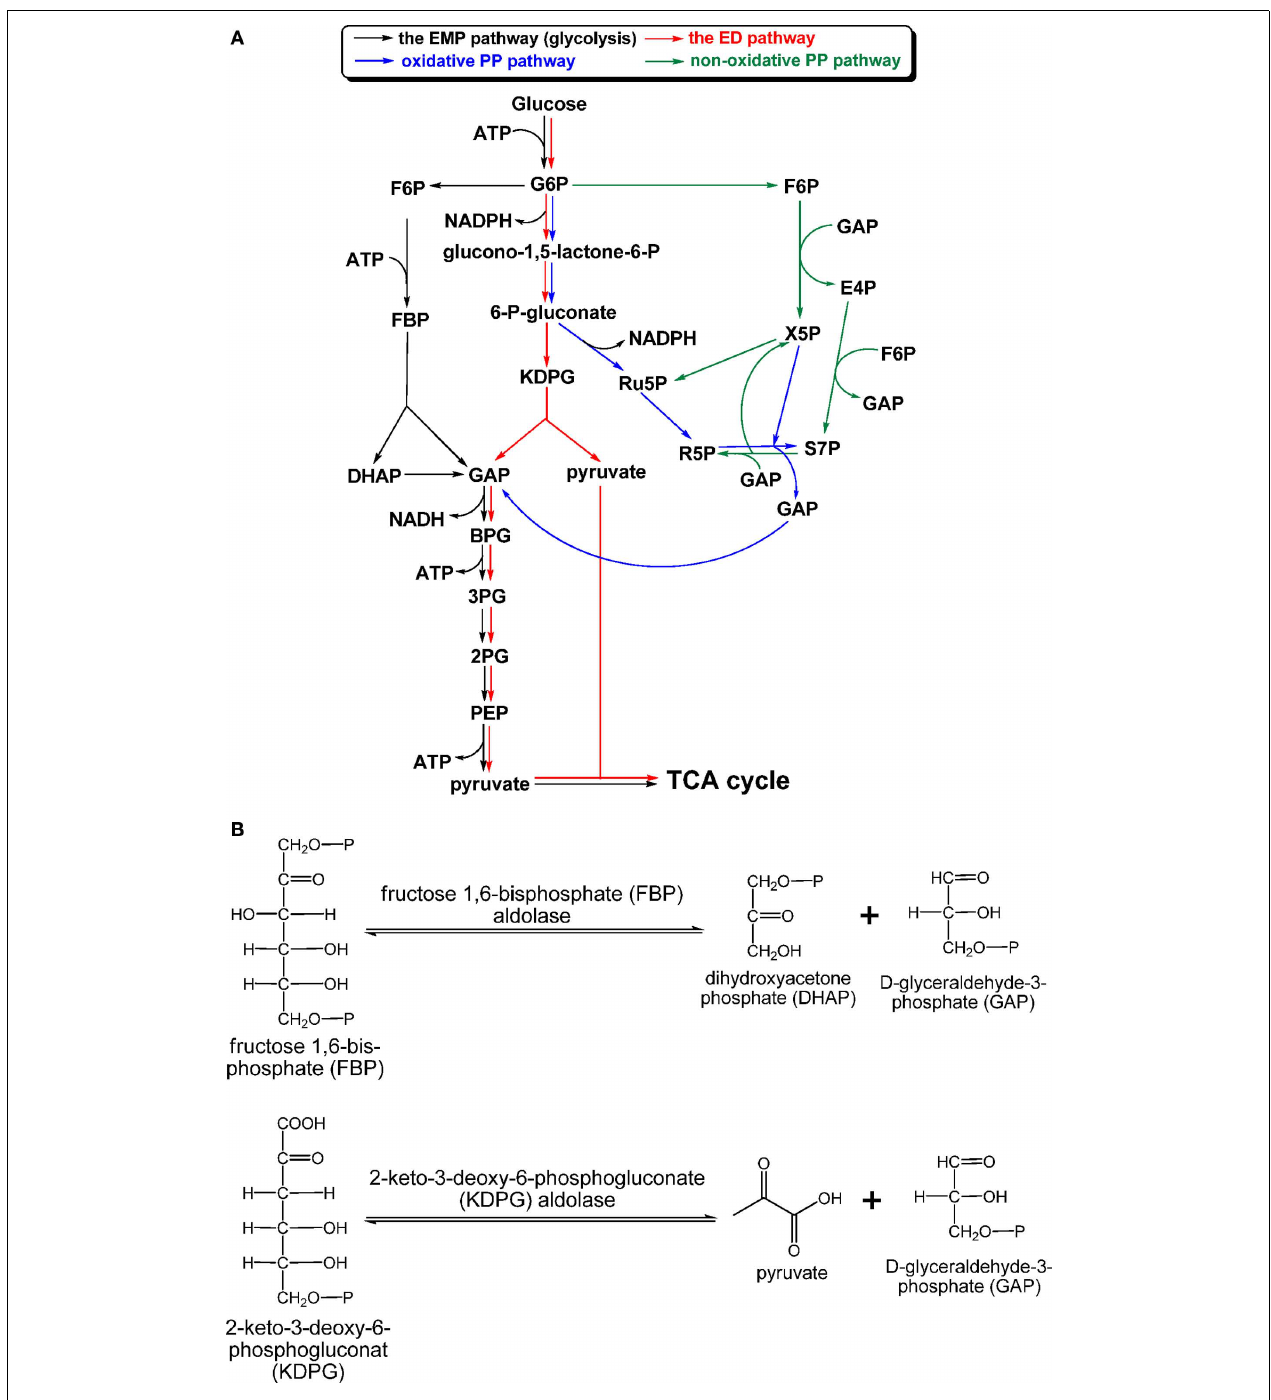
EMP/gluconeogenic pathway and KDPG aldolase in the ED pathway are shown in (B) . Abbreviation: EMP, Emden–Meyerhof–Parnas; ED, Entner–Doudoroff; KDPG,